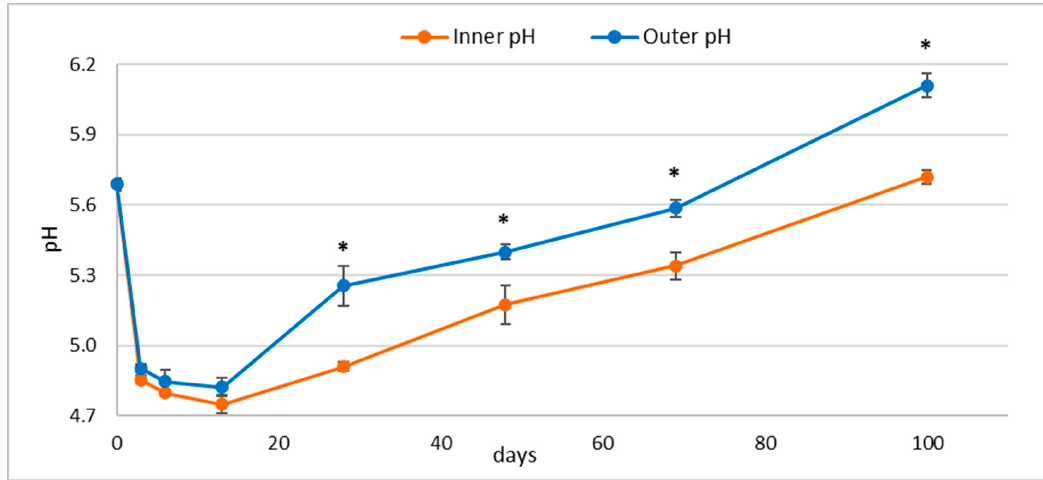
Figure 1. Evolution of pH during the 100 days ripening period in the inner and in the outer section of Ventricina samples. Standard error bars are showed. Sampling times with an asterisk were characterized by significant differences between samples according to Mann-Whitney test.